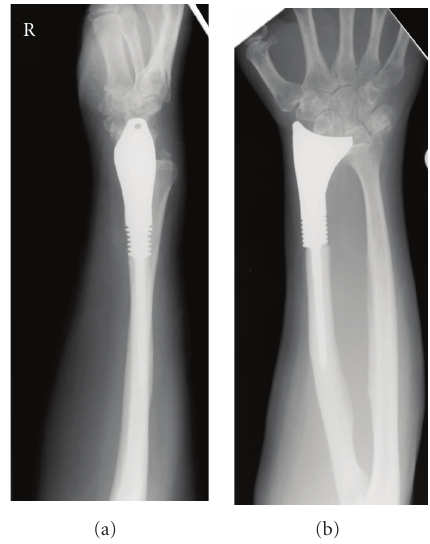
Figure 3: Radiographs of the distal forearm taken post-operatively at most recent follow-up, demonstrating the distal radial prosthesis and mild degenerative changes within the